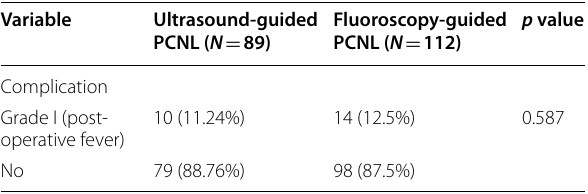
Table 4 Complication classified by a modified